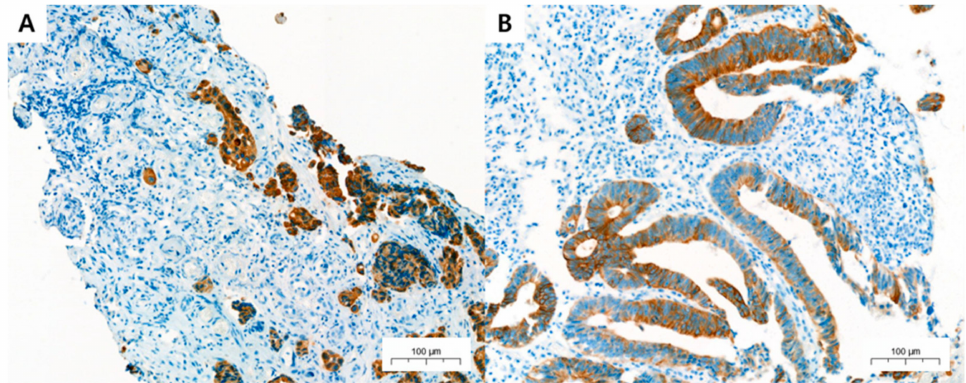
Figure 2. Representative microscopic foci of ( A ) high- and ( B ) low-grade intratumoral budding (ITB) in the pretreatment biopsy samples (PBSs) of colorectal carcinoma (CRC) on pancytokeratin immunohisto- chemical staining. ( A , B , pancytokeratin AE1/AE3 immunohistochemistry staining; 200